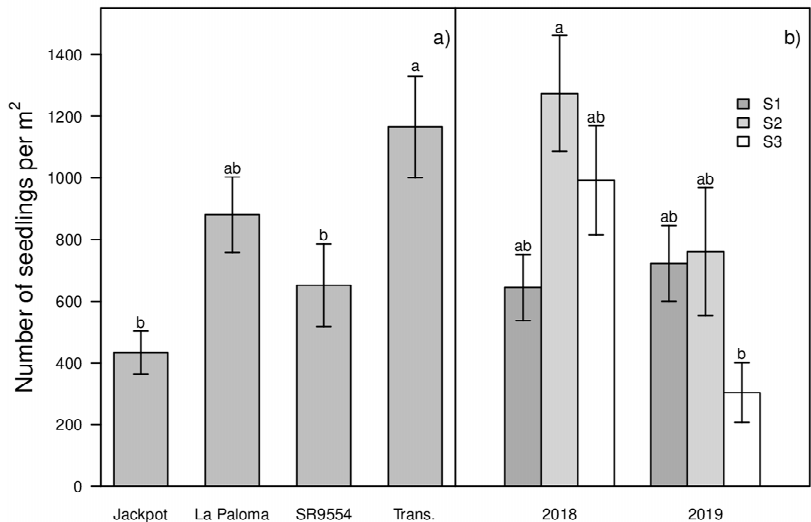
Figure 4. Number of seedlings as a ff ected by the main e ff ect of the cultivar ( a ) and the interaction between year and seeding time ( b ). Trans. = Transcontinental. Values with the same letter are not significantly di ff erent (Fisher’s protected LSD test at the 0.05 probability level). Vertical bars represent standard errors.